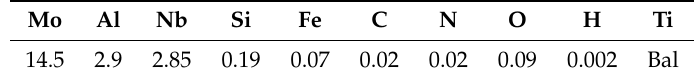
Table 1. Chemical composition of the TB8 titanium alloys (Wt.%).